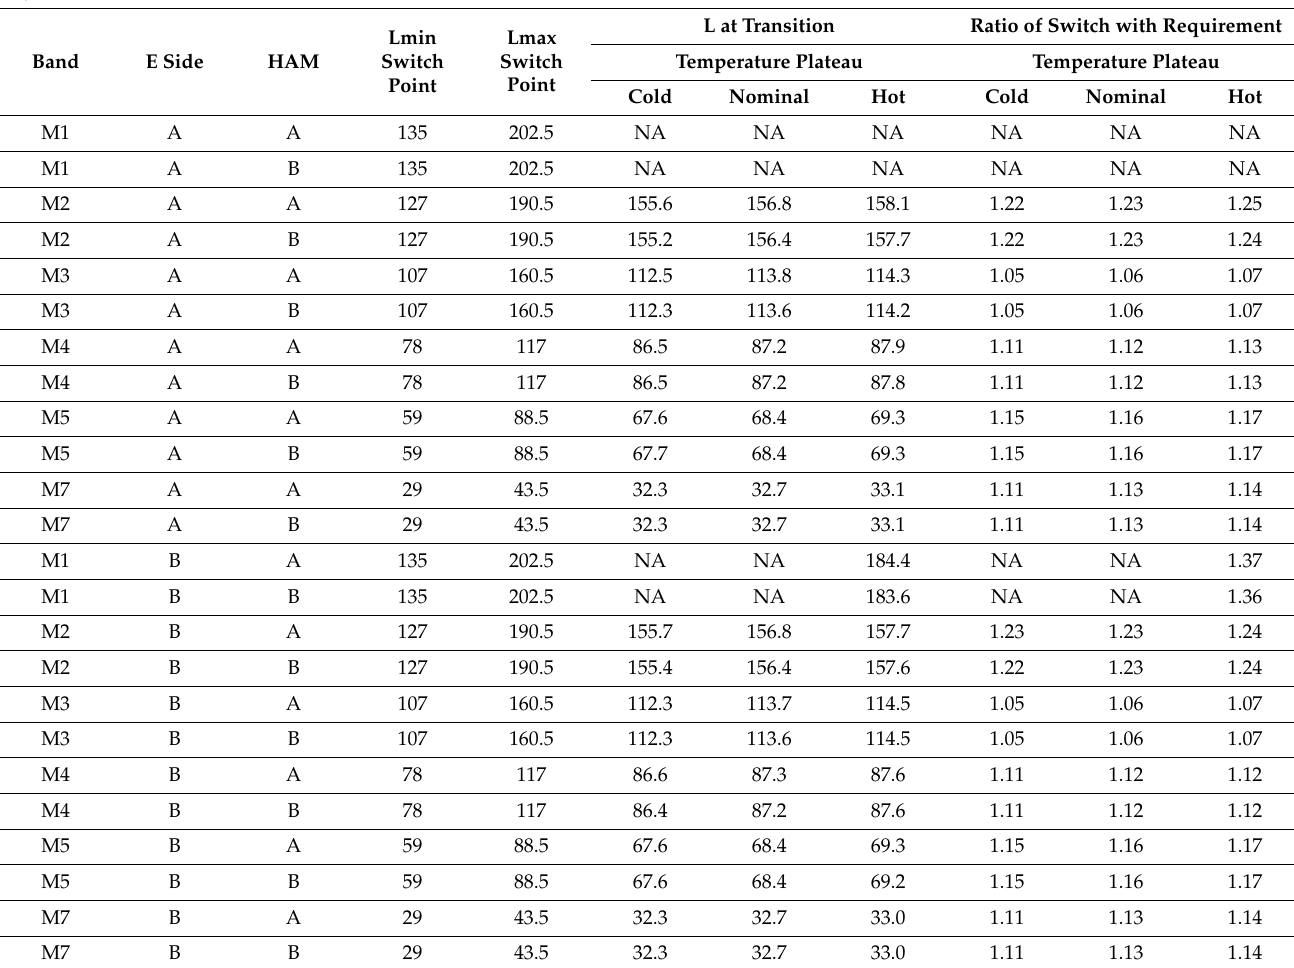
Table 3. JPSS-2 VIIRS dual gain switching for all the RSBs. The dual gain switching for band M1 could not be measured for most configurations due to the limited maximum radiance output of the